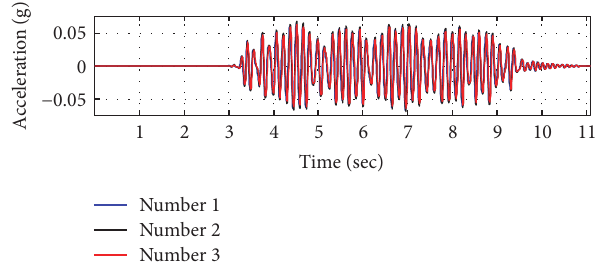
Figure 5: Random signal records by using three identical accelerometers to evaluate the accuracy of